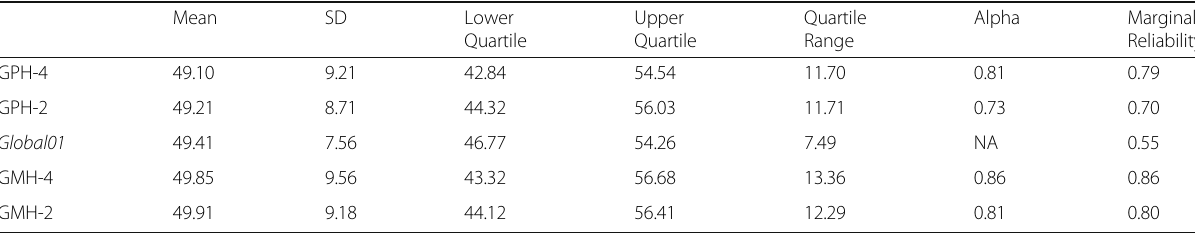
Table 1 Means, Standard Deviations, and Reliability Estimates for PROMIS Global Health Scales Mean SD Lower Upper Quartile